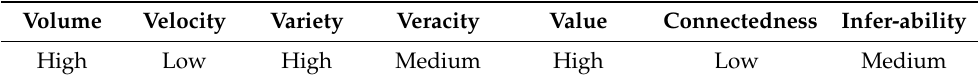
Table 2. Importance of different big data aspects for tourism